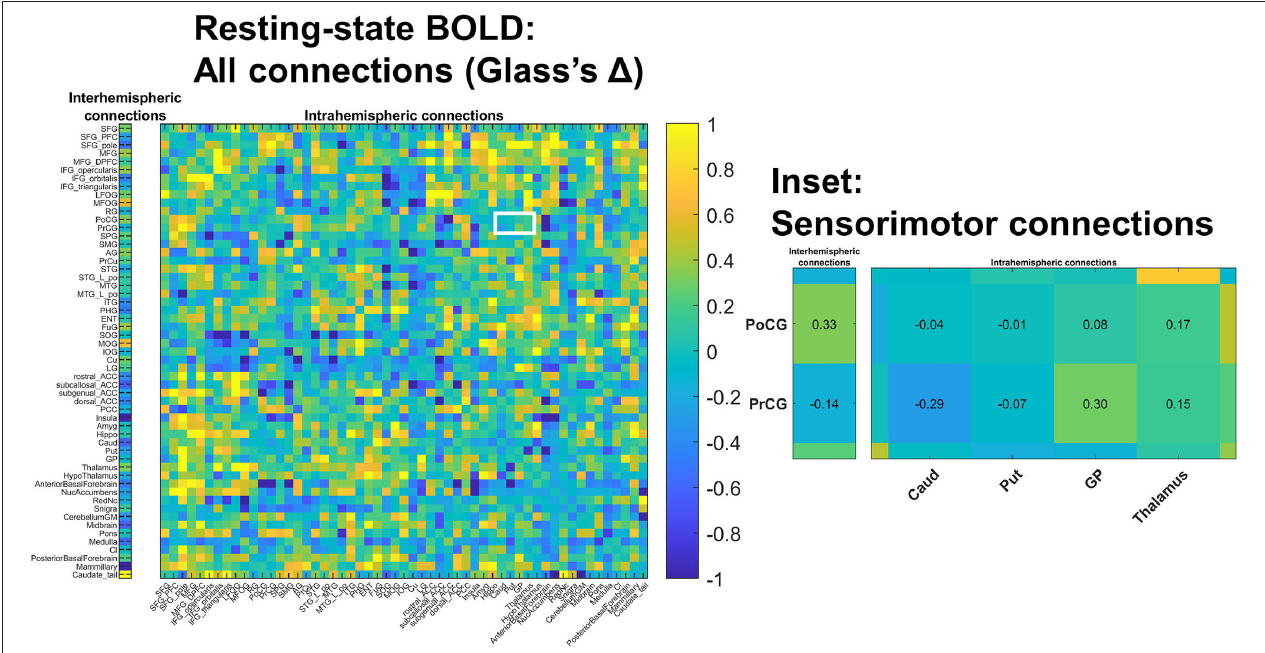
FIGURE 3 | Changes in resting state BOLD functional connectivity: All connections. Functional connectivity was assessed in a non-selective manner including both intra -hemispheric connections (right) as well as inter -hemispheric connections (left) . No differences survived multiple comparisons correction; colors indicate estimated standard effect size (Glass’s 1 ). The white-outlined rectangle highlights cortical-deep gray sensorimotor connections (inset); estimated 1 values are shown in inset cells. Groupwise functional connectivity in sensorimotor connections did not grossly change PRE- vs.